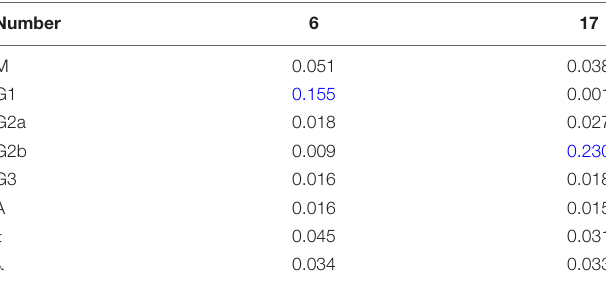
TABLE 3 | Analysis of monoclonal antibody